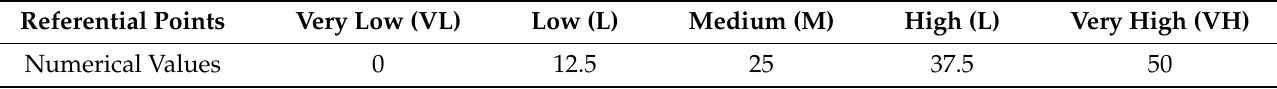
Table 5. The referential points and corresponding numerical values of antecedent lymphocytes.